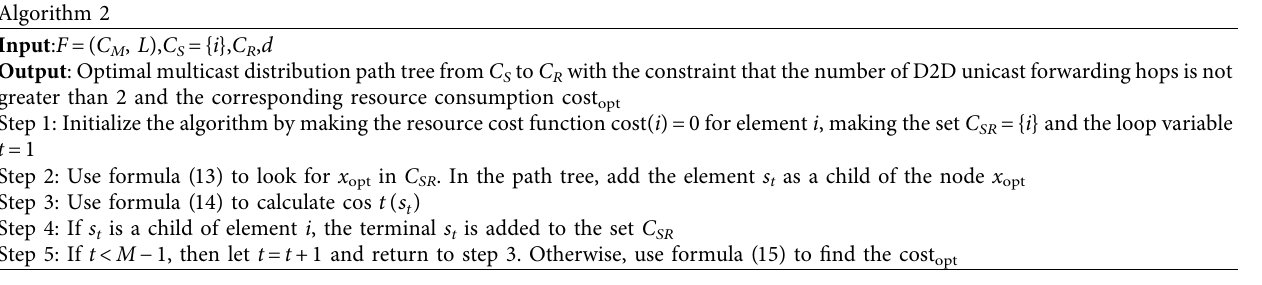
Table 2: Detailed steps of D2D unicast cooperative distribution algorithm based on multihop relay. Algorithm 2